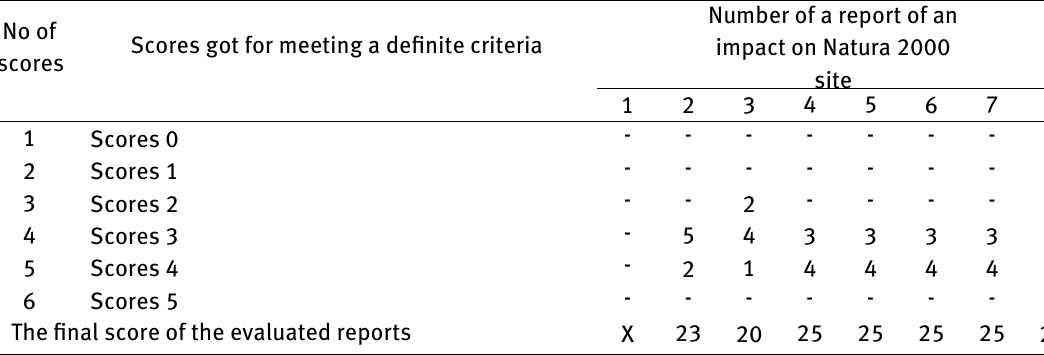
Table 3: The number of the scores in the scale adopted at the beginning of the study.